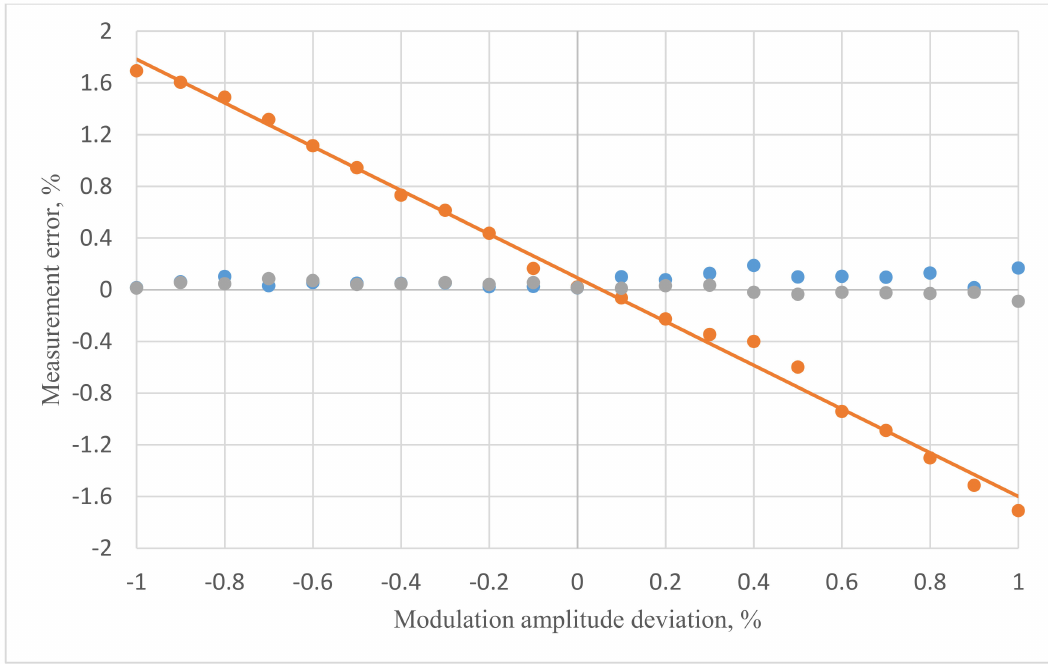
Figure 8. Measurement error vs modulation amplitude deviation of the optimal value in the range of ± 1%. Blue—compensation with coe ffi cients during numerical simulation, orange—without compensation, black—compensation with experimentally selected coe ffi